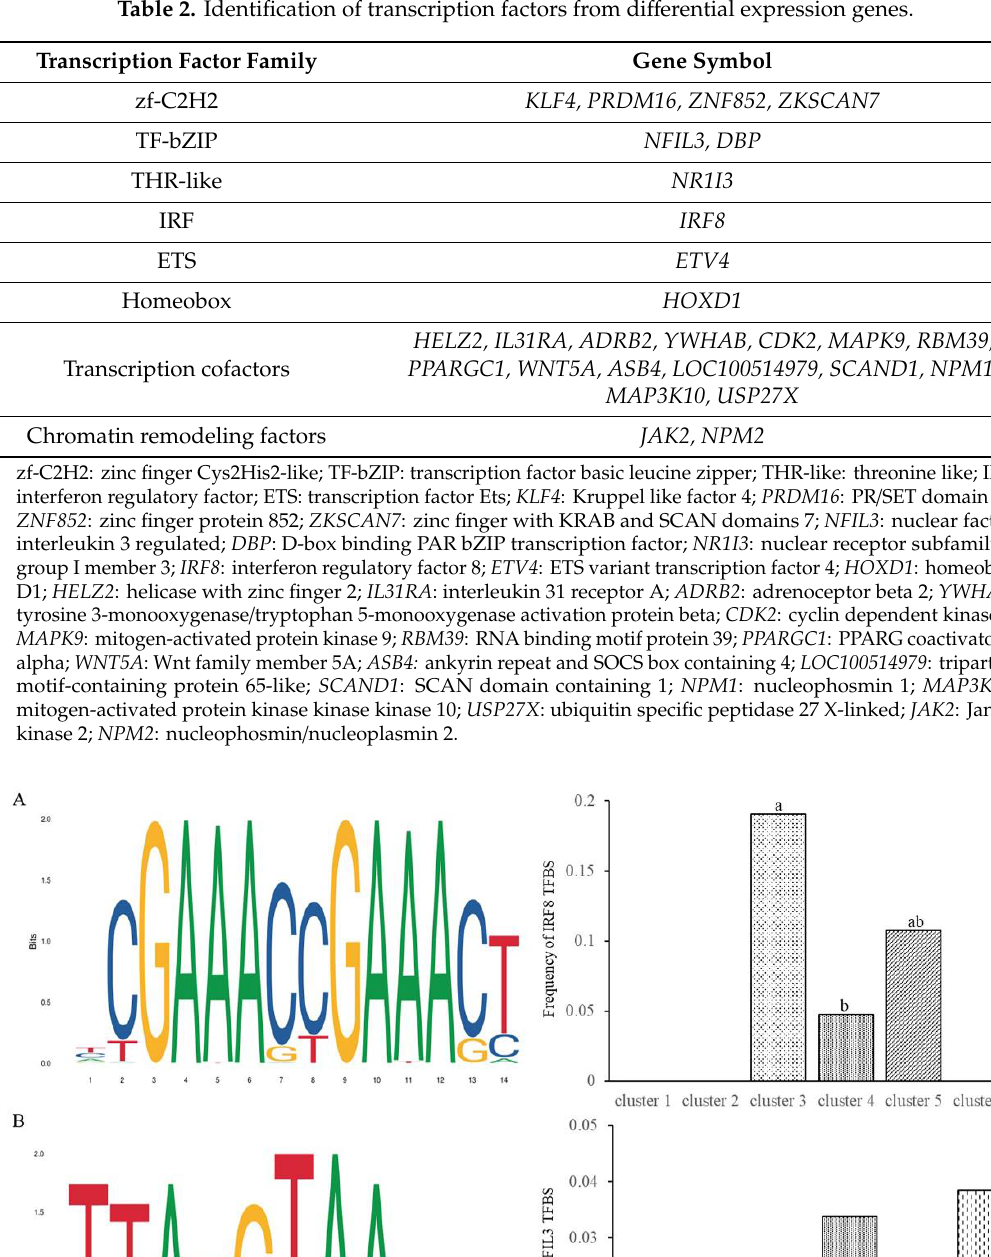
Figure 4. Occurrences of putative transcription factor binding sites (TFBSs) motifs of transcription factors ( A ) IRF8, ( B ) NFIL3, and ( C ) KLF4 in the promoter regions of various gene clusters. Bars with different letters (a, b, ab) indicate significant differences at the significance level of α = 0.05. 3.5. Alterations in H3K4me3 Patterns in the PEDV-Infected Jejunum To investigate the alterations of H3K4me3 patterns in the PEDV-infected jejunum, we performed global mapping of H3K4me3 modification using ChIP-seq. The H3K4me3 peak distributions near the transcription start site (±5 kb) of the annotated pig genes were analyzed. The H3K4me3 peaks showed higher enrichment in the regions close to the transcription start sites (Figure 5A). Compared to the controls, 1885 peaks associated with 1723 genes were identified (Table S9). We then performed GO analysis for the genes associated with H3K4me3 modification. These genes were highly enriched in categories including regulation of cell morphogenesis involved in differentiation, cytosolic transport, and regulation of stress-activated MAPK cascade (Table S10). Integrative analysis of H3K4me3 enrichment and gene expression data of the PEDV-infected jejunum showed that most promoters of the up-regulated genes demonstrated higher H3K4me3 enrichment, and those of down-regulated genes displayed lower H3K4me3 enrichment (Figure 5B), indicating the associations of H3K4me3 with transcriptional activity. A subset of genes including OAS1 , OAS2 , EFNB2 , and CKS1B involved in the immune response to viral infection showed a higher expression level (Figure 5C) and H3K4me3 enrichment (Figure 5D) in PEDV-infected samples, suggesting the role of H3K4me3 deposition in promoting their expression.